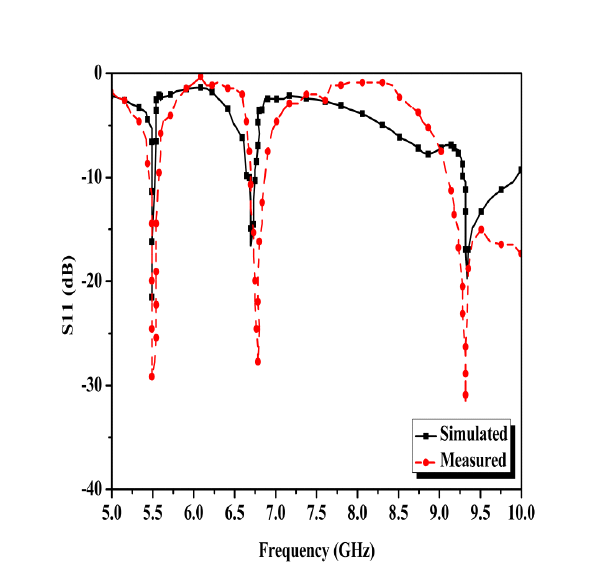
Figure 6: b. Comparison of Return Loss of experimentally measured and simulated proposed Antenna.